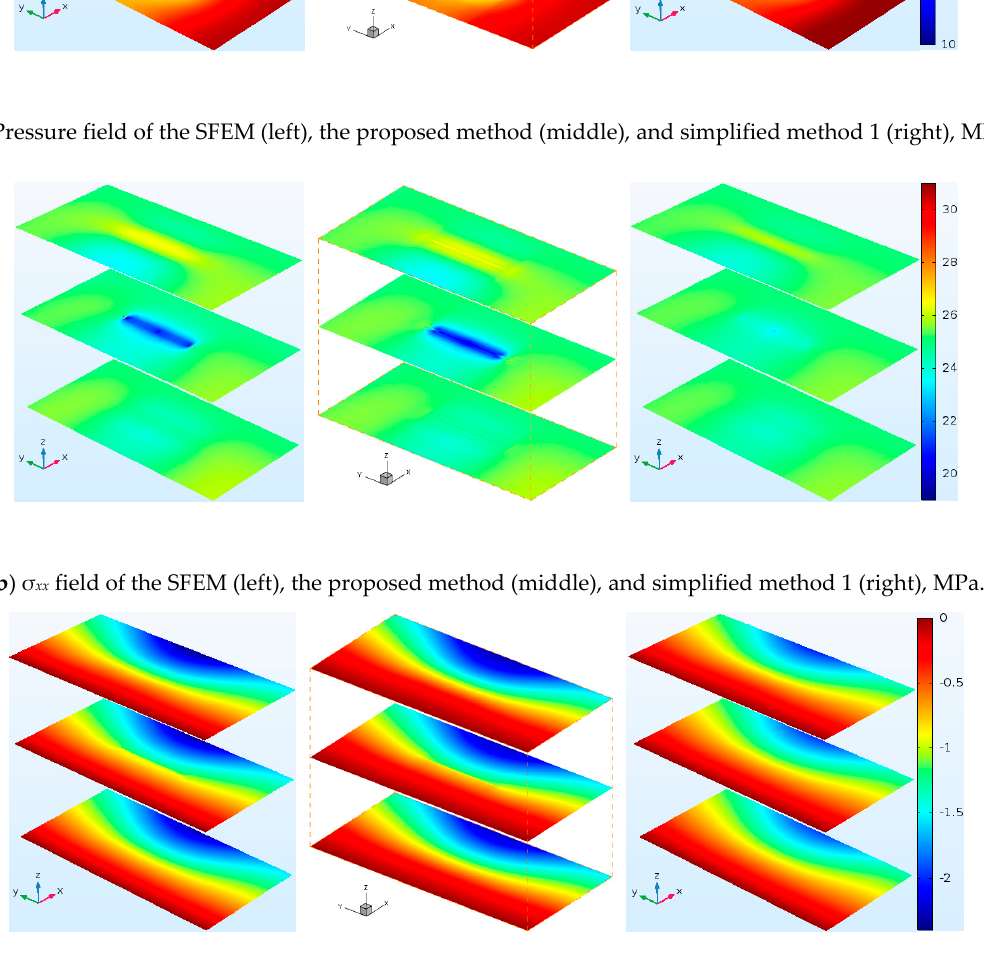
Figure 9. Comparisons of pressure, x -stress and x -displacement for different methods after 1000 days. The profiles are shown in the top, middle and bottom layers, and the length in the z -direction is shown at five times the real size.